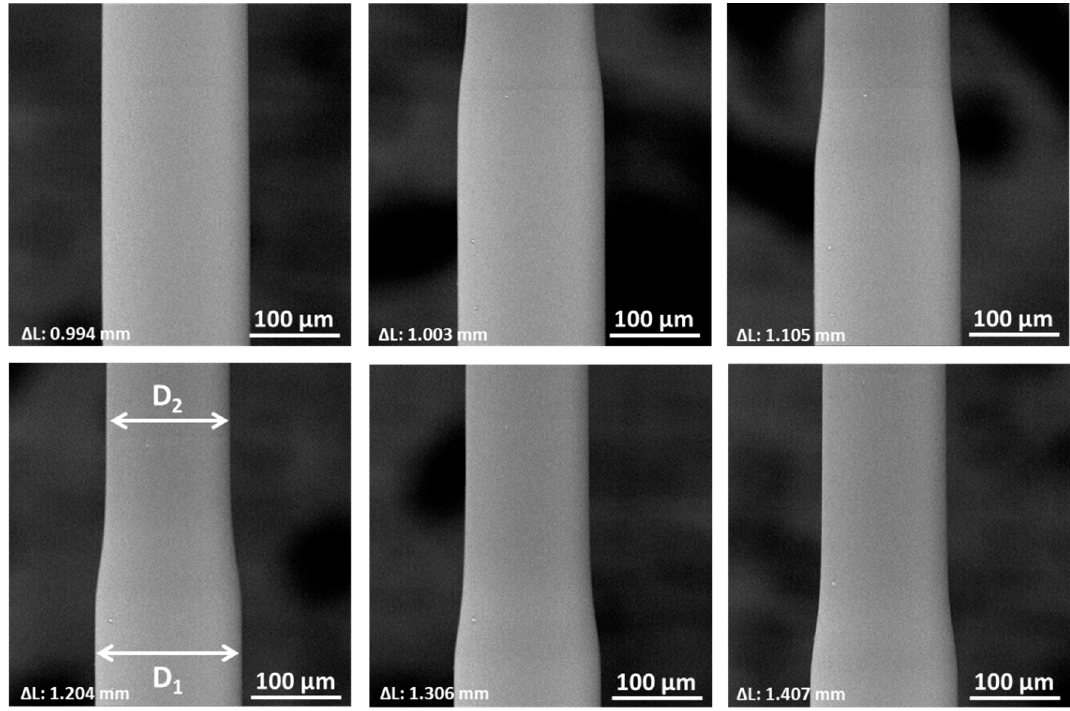
Figure 6. Sequential SEM images of necking in a microfiber. ∆ L indicates the displacement of the clamps.